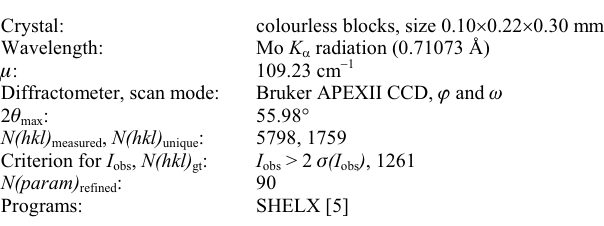
Table 1. Data collection and handling.